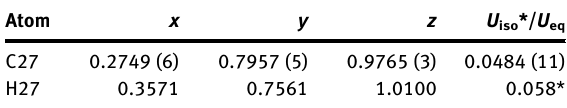
The asymmetric unit of the title complex contains a Zn(II) cation, one coordinated water molecule, one 3,3 ′ ,4,5 ′ -biphenyl tetracarboxylate ligand and one half of the 4,4 ′ bis(pyrid-4-yl) biphenyl ligand. The cation is five- coordinated with a distorted octahedral geometry by three O atoms from two H4btc units, one water molecule, and (see the figure). All bond lengths and angles are within the